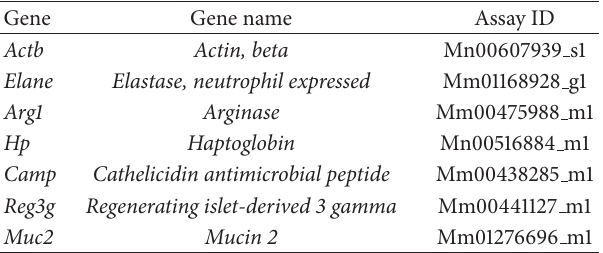
Table 1: Gene expression assays used for